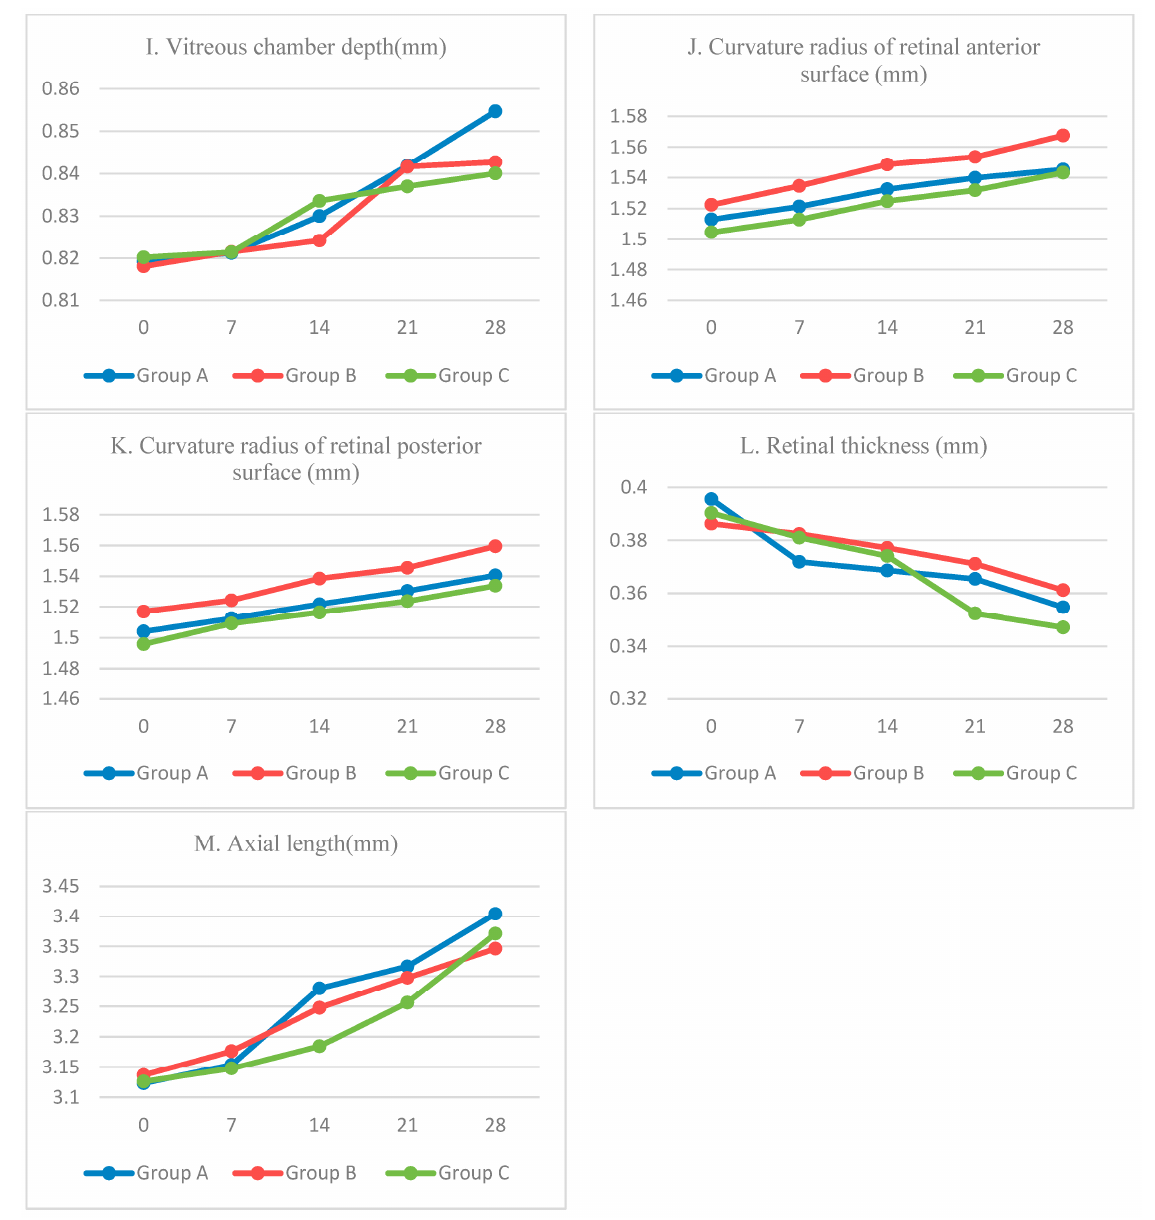
Figure 6. Time-serial development of biological structure parameters. Group A: FDM myopia model group; Group B: normal control group; Group C: atropine treatment group.